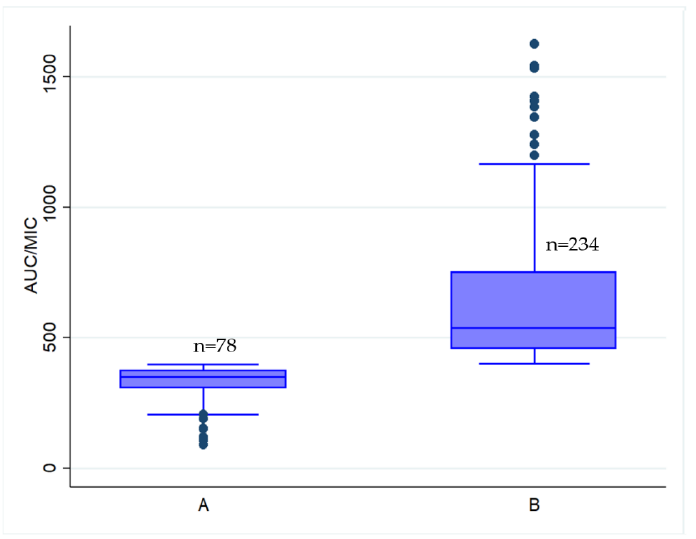
Figure 1. Distribution of AUC/MIC values. ( A ) AUC/MIC of <400 mg•hr/L and ( B ) AUC/MIC of ≥400 mg•hr/L. BestDose program uses a Bayesian estimation algorithm to update preset pharmaco- kinetic parameters (prior probabilities) with the available data. The prior distribution of parameters derived from BestDose software (Table 2). Table 2. Pharmacokinetic parameters used for predictions **.